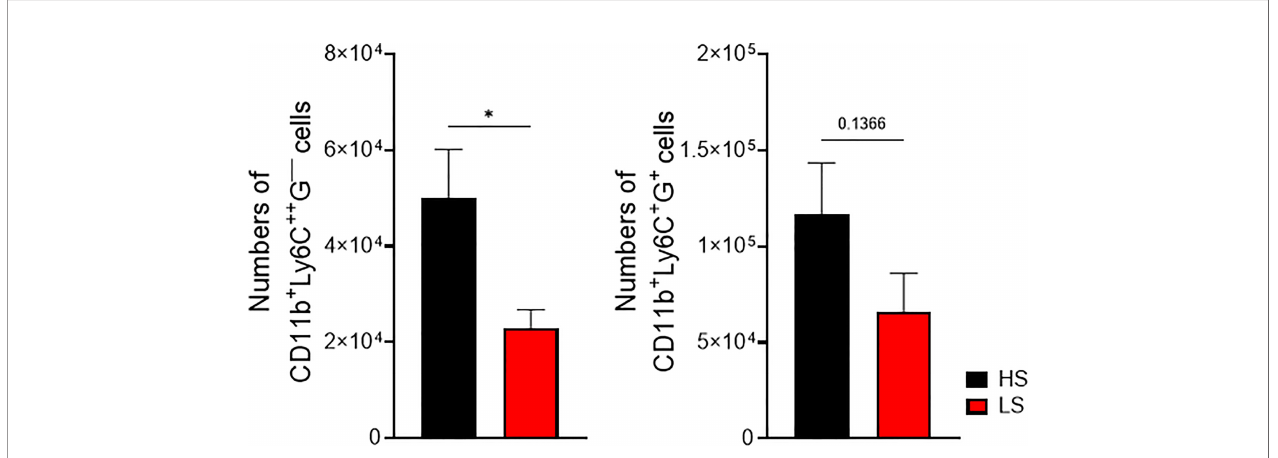
FIGURE 9 | Inhibition of leukocyte extravasation by low-salt diet in thioglycollate-induced peritonitis. Mice were fed with low and high salt diets for 2 weeks before inducing peritonitis. Peritoneal fl uid was harvested and analyzed for CD11b + Ly6C ++ Ly6G - and CD11b + Ly6C + Ly6G + in fi ltrated cells by fl ow cytometry (LS, n = 13 HS, n = 12). * p < 0.05. p -values were calculated by Student ’ s t -test. All data were expressed as ± SEM.